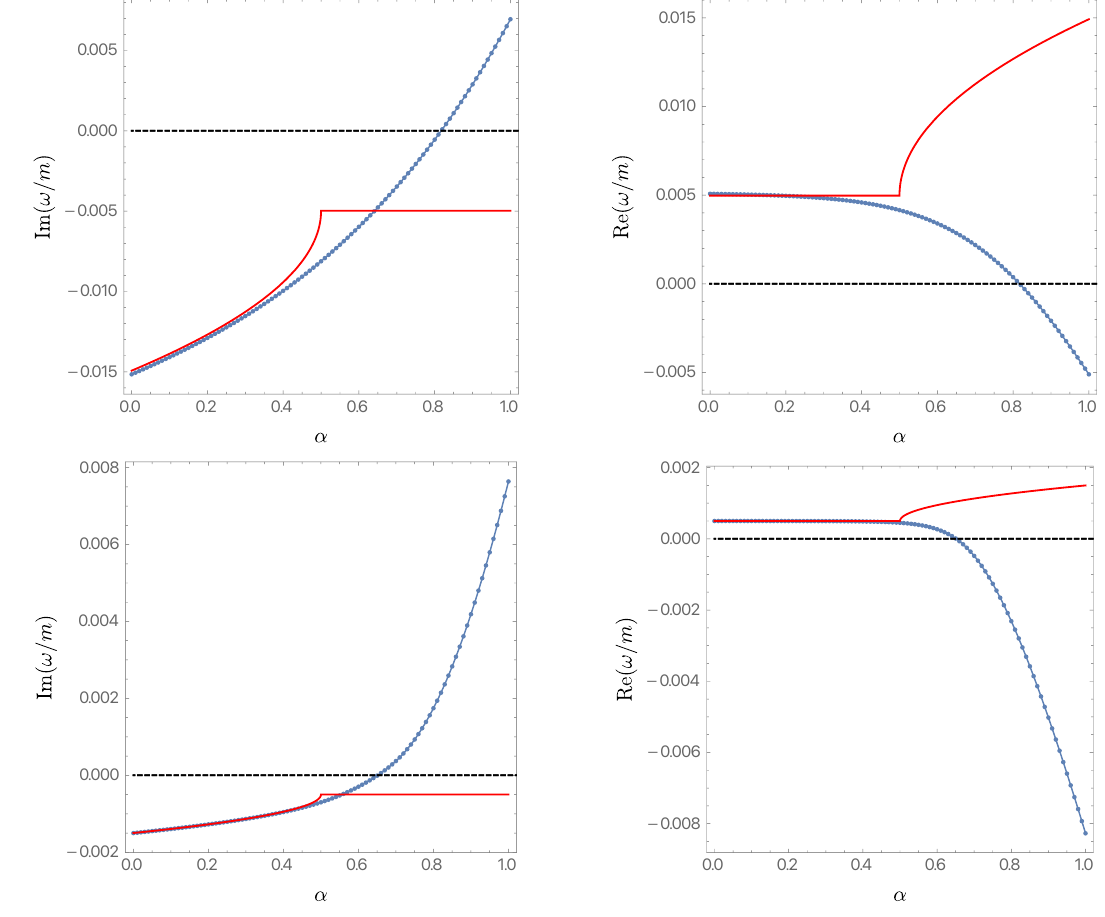
Figure 12 . Imaginary (left column) and real (right column) parts of ω as a function of α for fixed q/m = 0 . 5 and m r + = 1 . The top row has µ = 0 . 99 , whereas the bottom row has µ = 0 . 999 . The disks represent numerical data, whereas solid red lines yield the analytic prediction given in